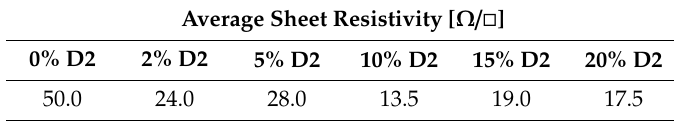
Table 2. The results of resistivity of the graphene layer Figure 6. The dependence of the resistivity on the percentage content of the surfactant in the ink.